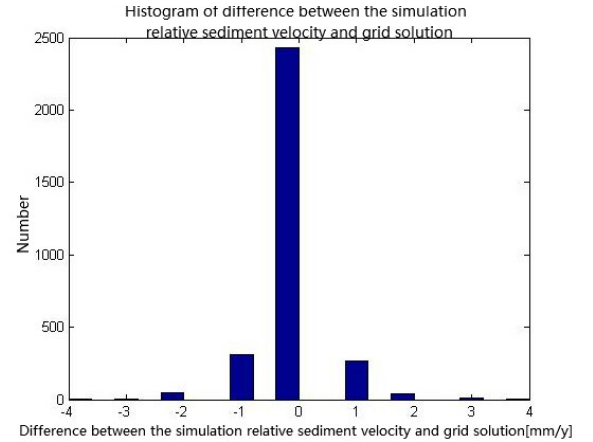
Figure 4 Histogram of difference between the simulation sediment velocity and grid search solution